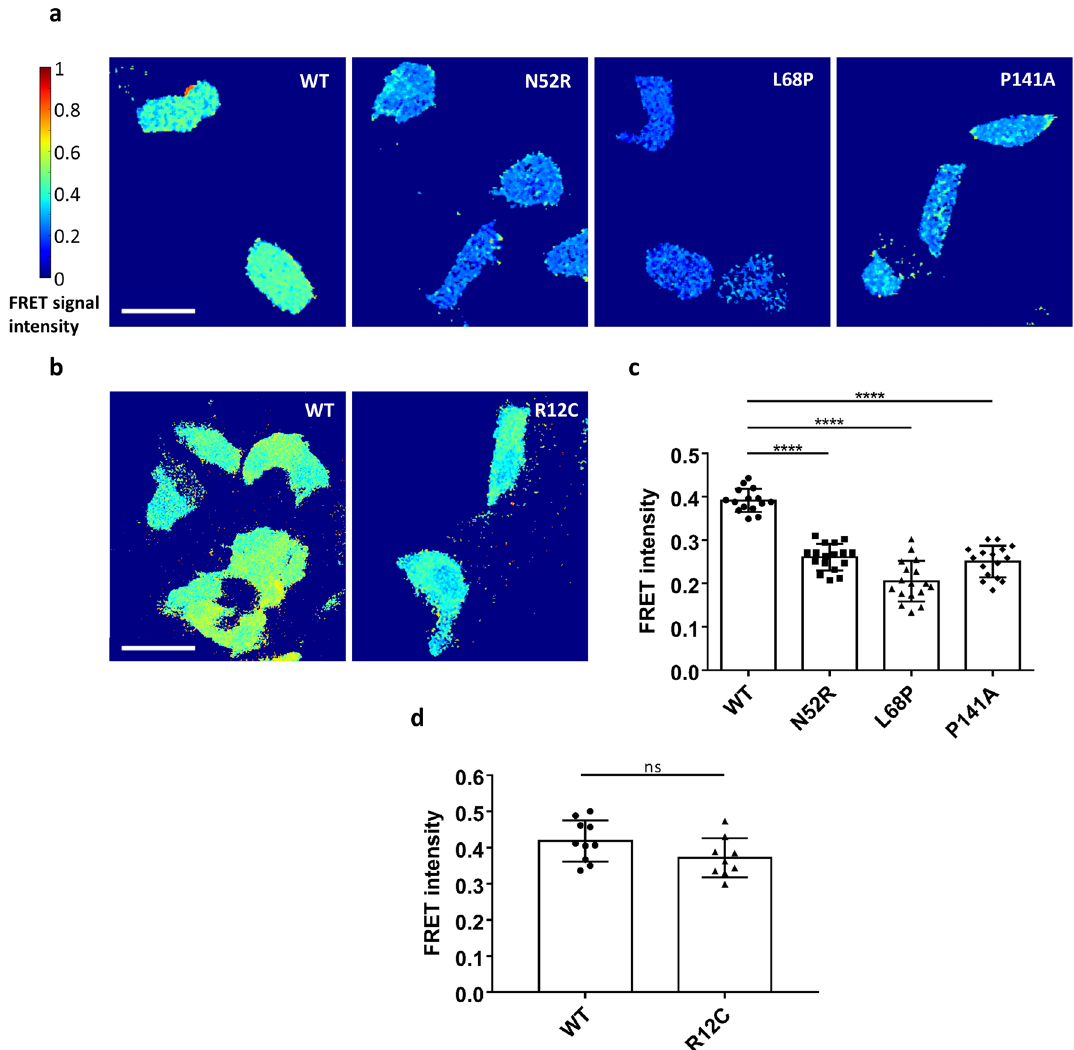
Figure 7. ( a ) 293 T cells transfected with Shank3 N-terminal FRET constructs coding for a fusion of N-terminal GFP, followed by WT or mutant Shank3 (residues 1–339, SPN + Ank), and C-terminal mCherry, were subjected to live cell imaging using a FRET imaging program (scale bar 50 µm). The FRET intensity was compared after 1 min. The color-coded FRET signal intensity (left) represents a low FRET signal (FRET = 0) with the dark blue color and a very high FRET signal FRET = 1 with the dark red color. ( b ) Repeat of the experiments shown in ( a ) with the R12C mutant (which is not in the interface between SPN and Ank domains). ( c ) Quantitative evaluation of cells shown in ( a ). ( d ) Quantitative evaluation of cells shown in ( b ). ****p < 0.0001; ANOVA, followed by Dunnett’s multiple comparisons test; ns: non-significant; t-test. Analysis of n = 15–17 cells ( a , c ) or n = 9–10 cells ( b , d ) from three independent